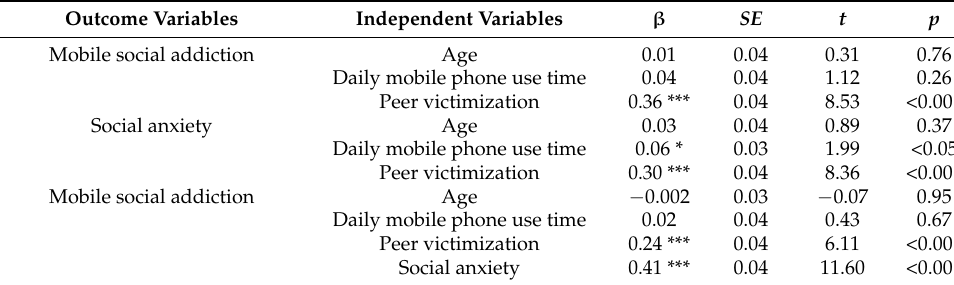
Table 3. Mediation analysis of the role of social anxiety.